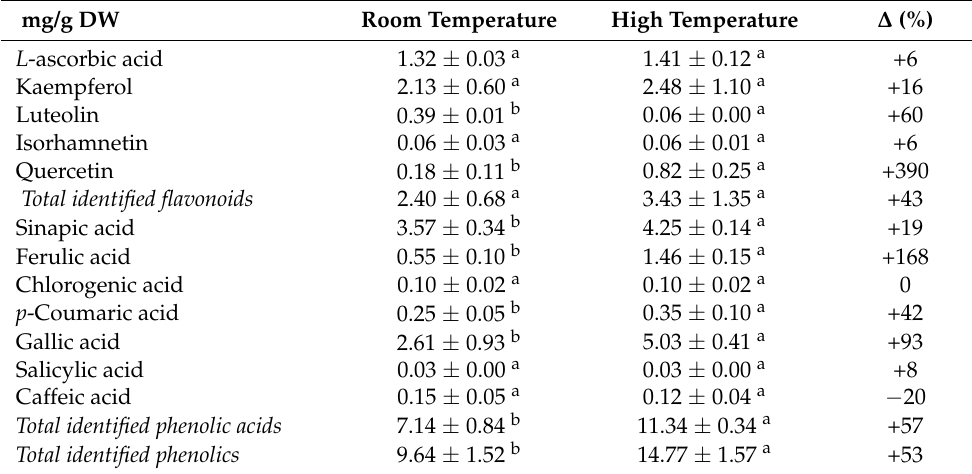
Table 3. Effect of high growing temperature on the concentration of L -ascorbic acid and individual phenolic components in broccoli